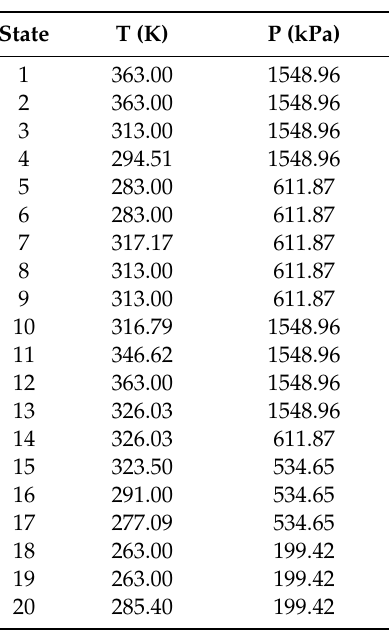
Table 3. Thermodynamic data of the compression–absorption cascade system using NH 3 -LiNO 3 solution and R134a as working